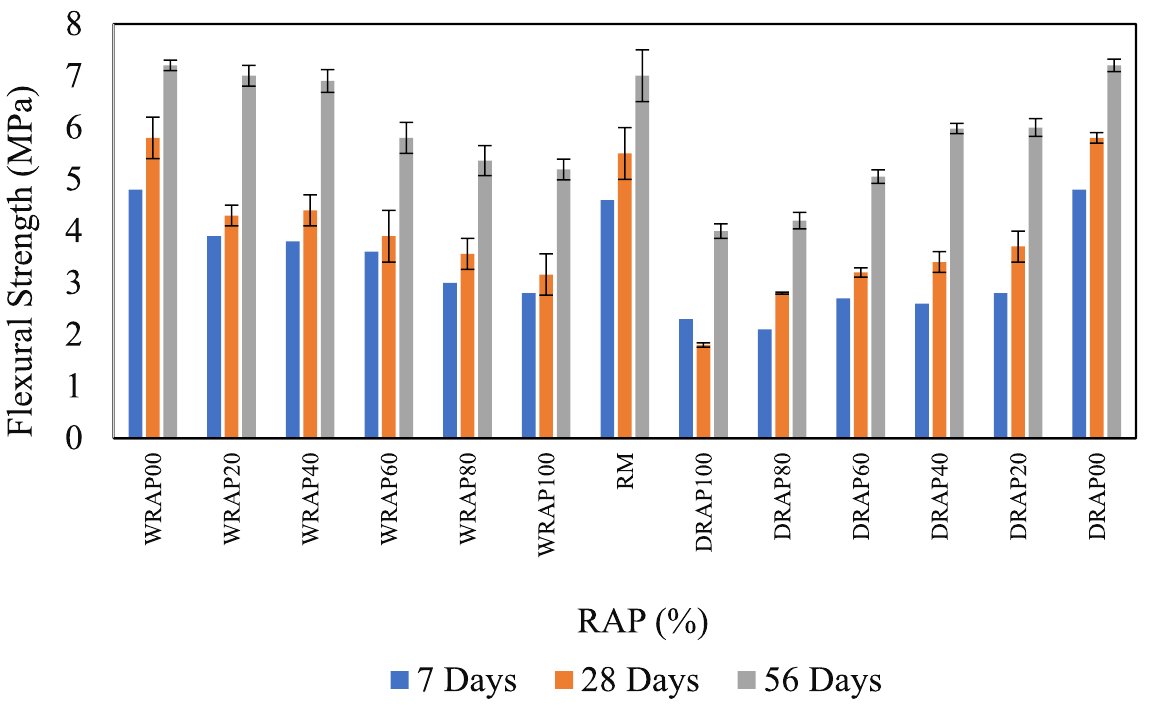
Figure 6. Influence of flexural strength in RAP-based concrete.